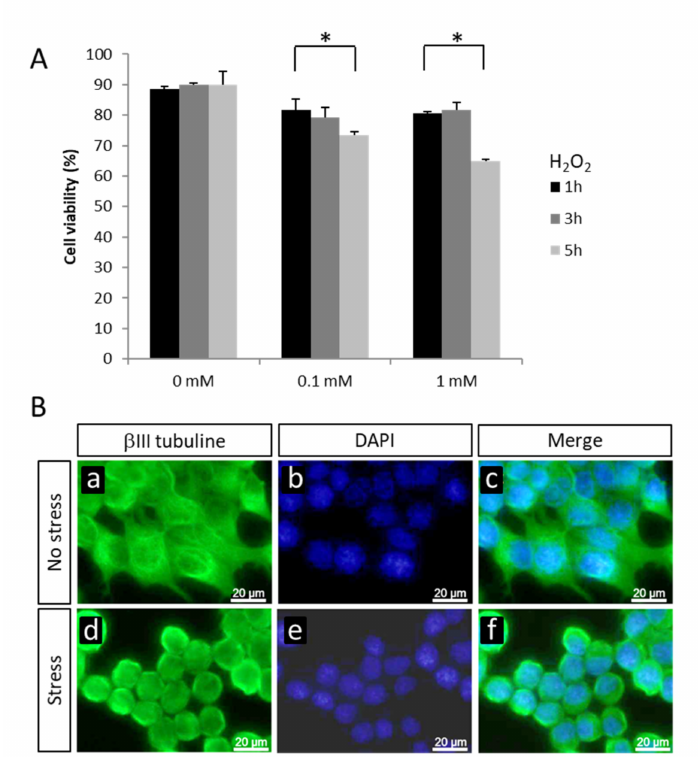
Figure 1. ( A ) Cell viability of non-transfected NSC-34 cells in absence or presence of 0.1 or 1 mM H 2 O 2 for 1, 3, or 5 h. * p < 0.05 nonparametric Mann–Whitney test. ( B ) Immunocytochemical visualization of β III-tubulin in NSC-34 cells in absence ( a , b , c ) or presence ( d , e , f ) of 1 mM H 2 O 2 for 3 h. Scale bar: 20 µ